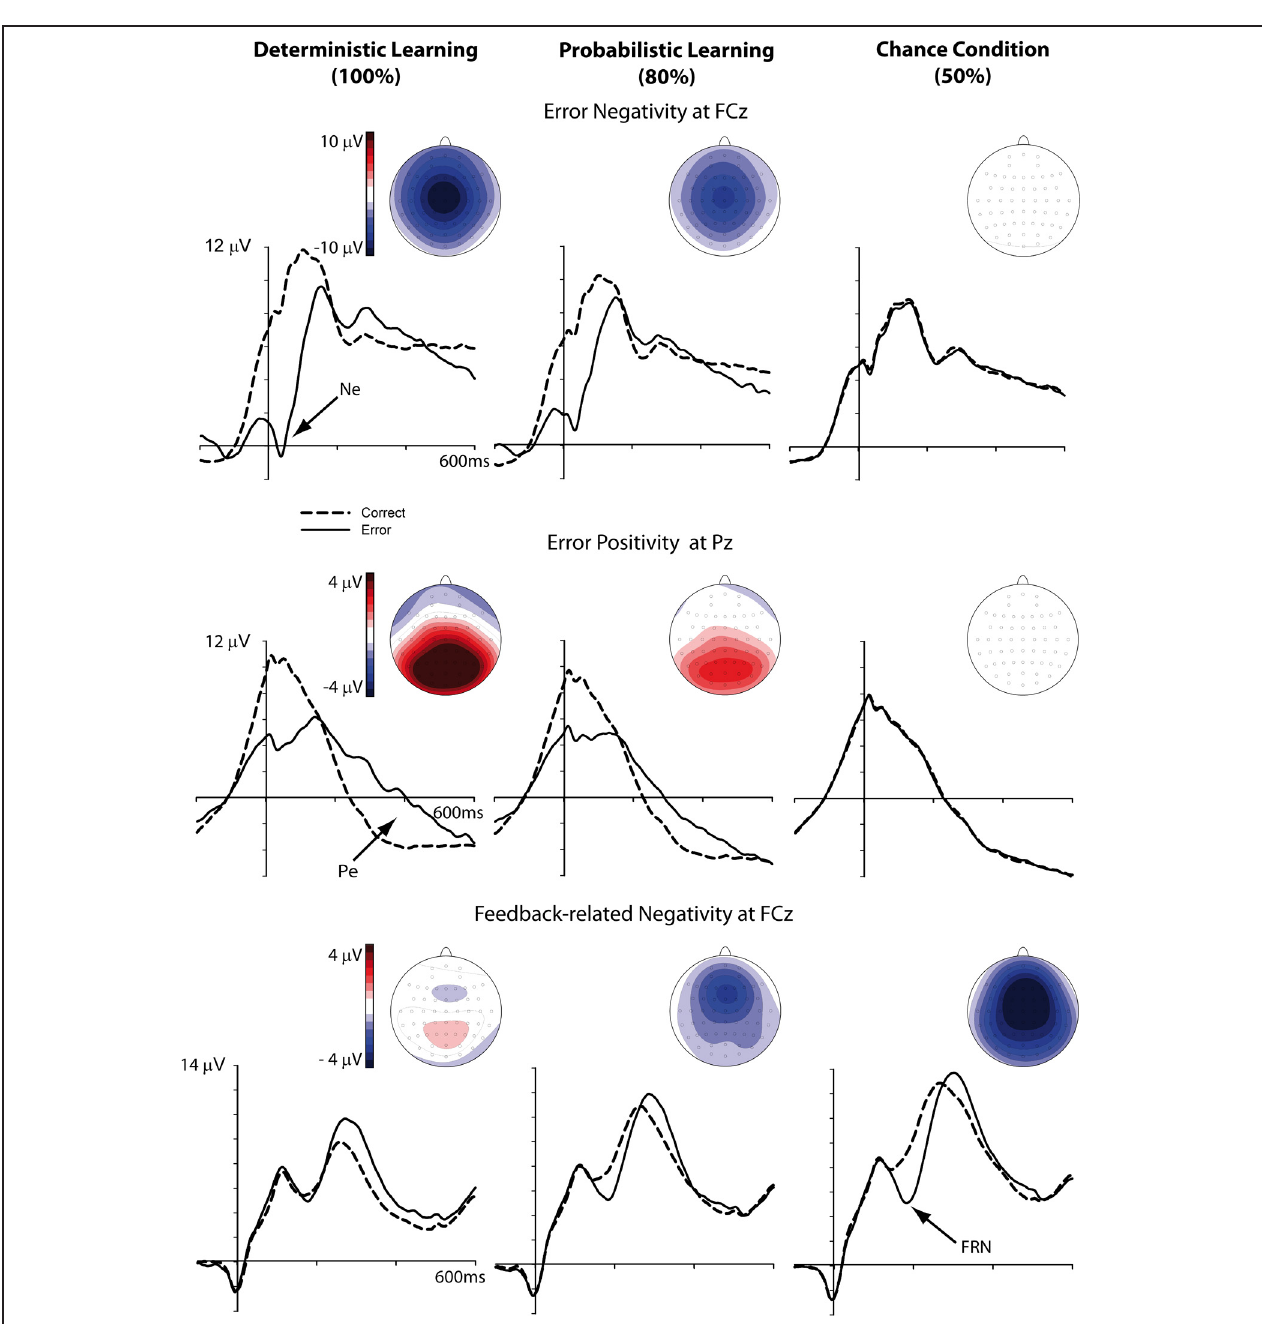
FIGURE 3 | Response- and feedback-locked ERPs on correct (dashed lines) and incorrect (solid lines) trials and corresponding topographical maps, displayed separately for the three learning conditions.